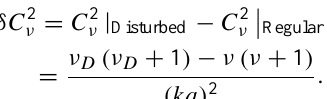
Fig. 3. Distance dependence of the amplitude of vertical electric field component at the frequency of 26Hz. Fig. 4. Scheme of ELF radio propagation in the Earth- ionosphere cavity with a localized disturbance placed over the earthquake epicenter.